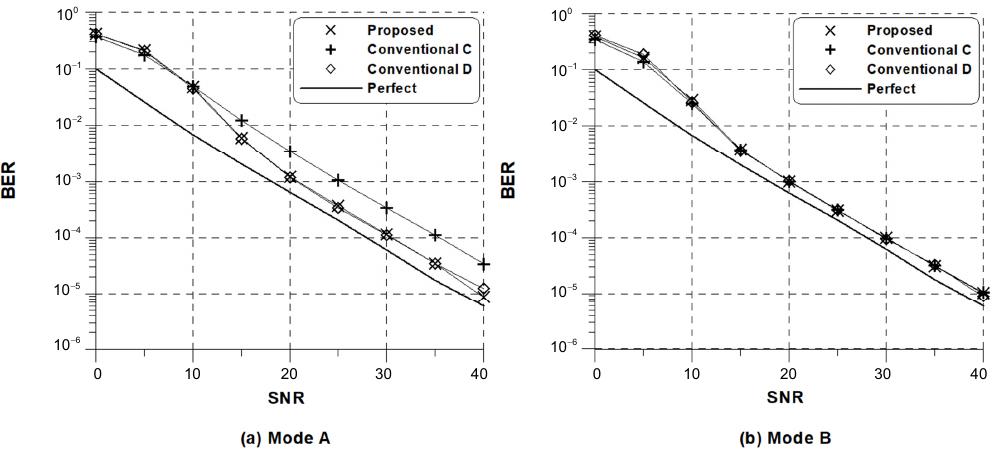
Figure 6. Bit error rate (BER) performance of the conventional and proposed frequency estimators in